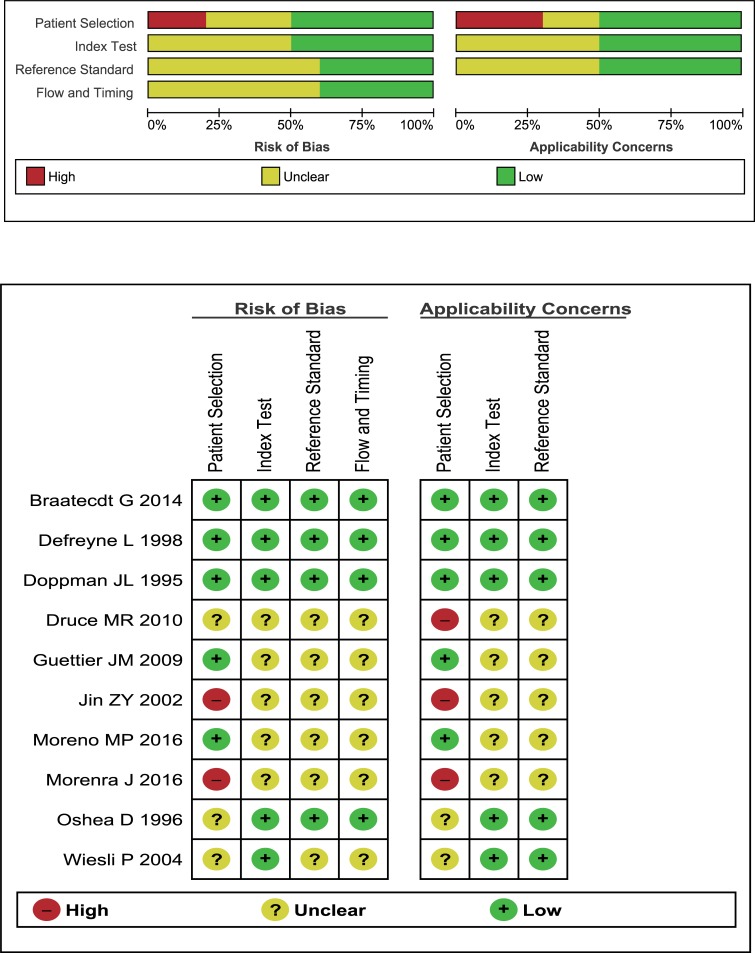
Quality assessments of the included studies.